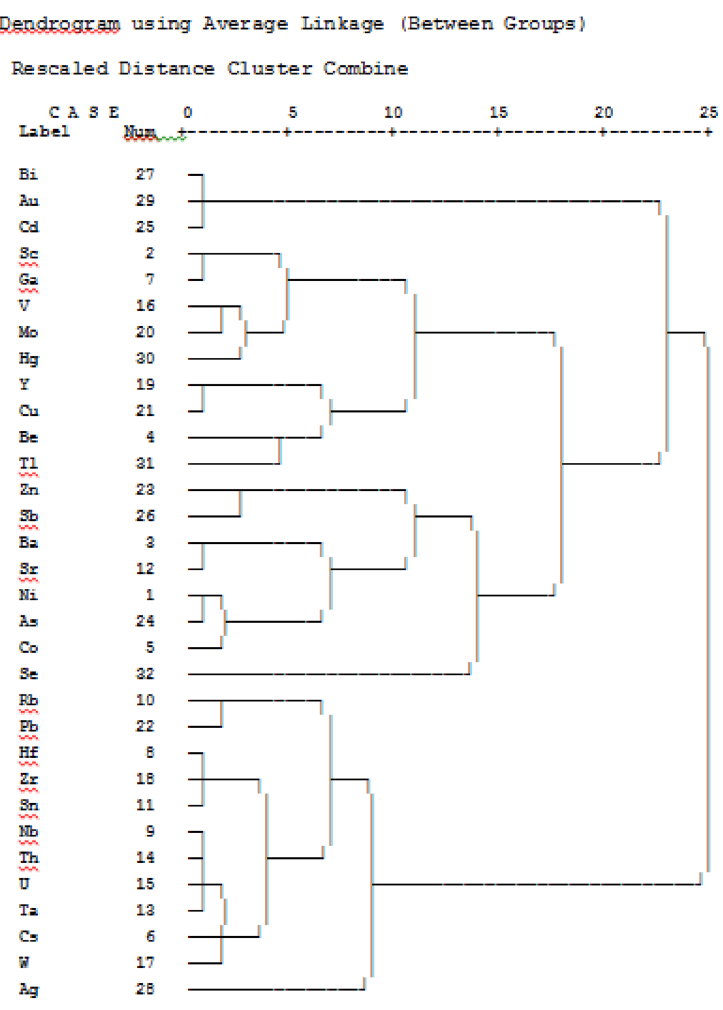
Fig. 8 Cluster result of trace elements in